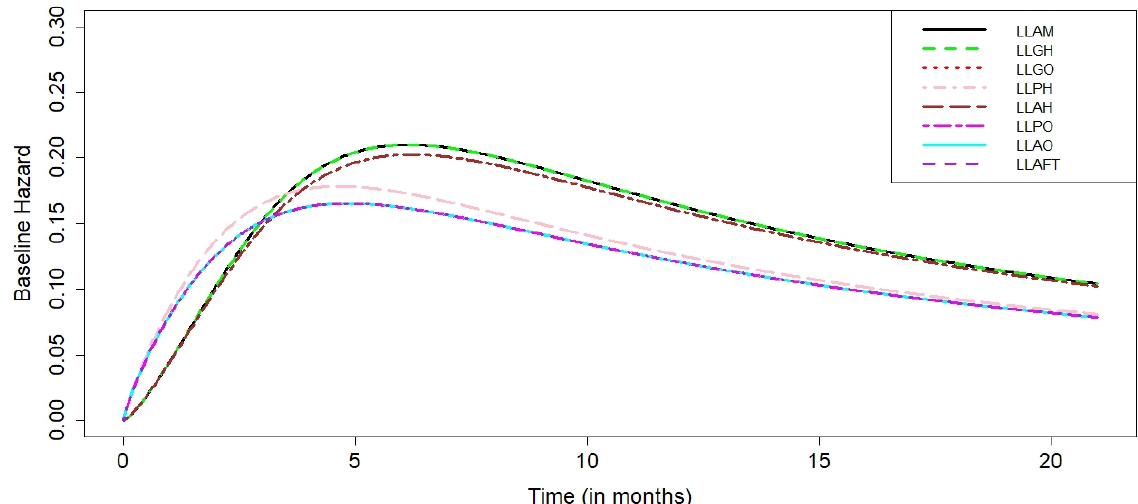
Figure 4. Estimated hrfs for the competitive models of the IPASS dataset.